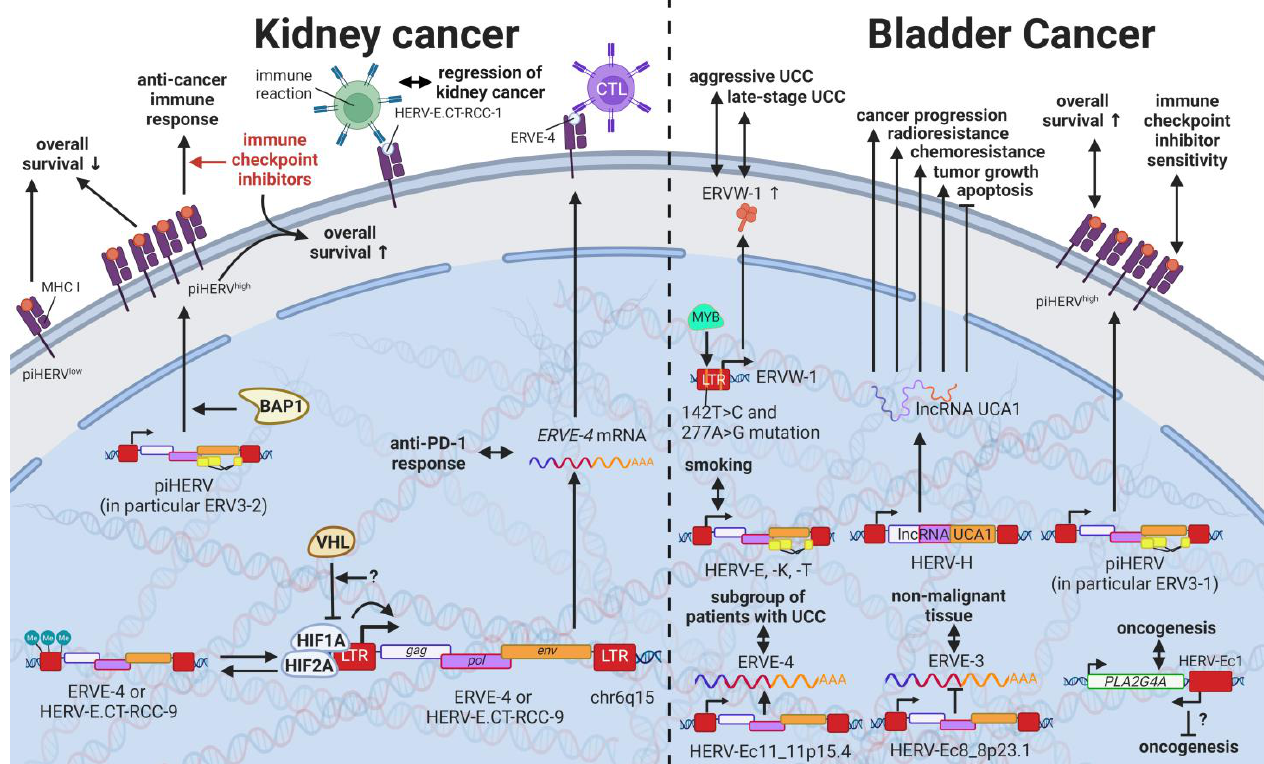
Figure 11. The role of HERVs in cancers of the urinary system. Evaluated treatments are marked in red. Abbreviations: CTL = cytotoxic T cell, UCC = urothelial carcinoma, RCC = renal cell carcinoma, piHERV = potentially immunogenic HERVs, LTR = long terminal repeat, gag = group antigen (capsid), pol = polymerase, env = envelope, HERV-K = HML-2.